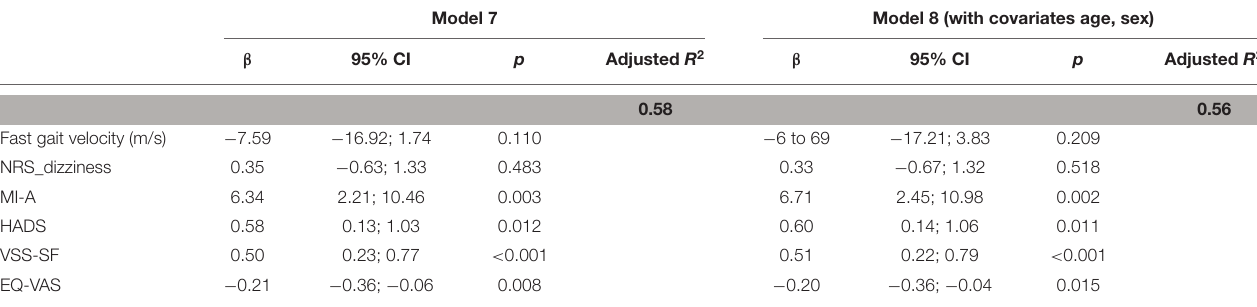
TABLE 4 | Association between the significant outcomes from models 4–6 and the total Dizziness Handicap Inventory (DHI) score, in participants with persistent dizziness. Model